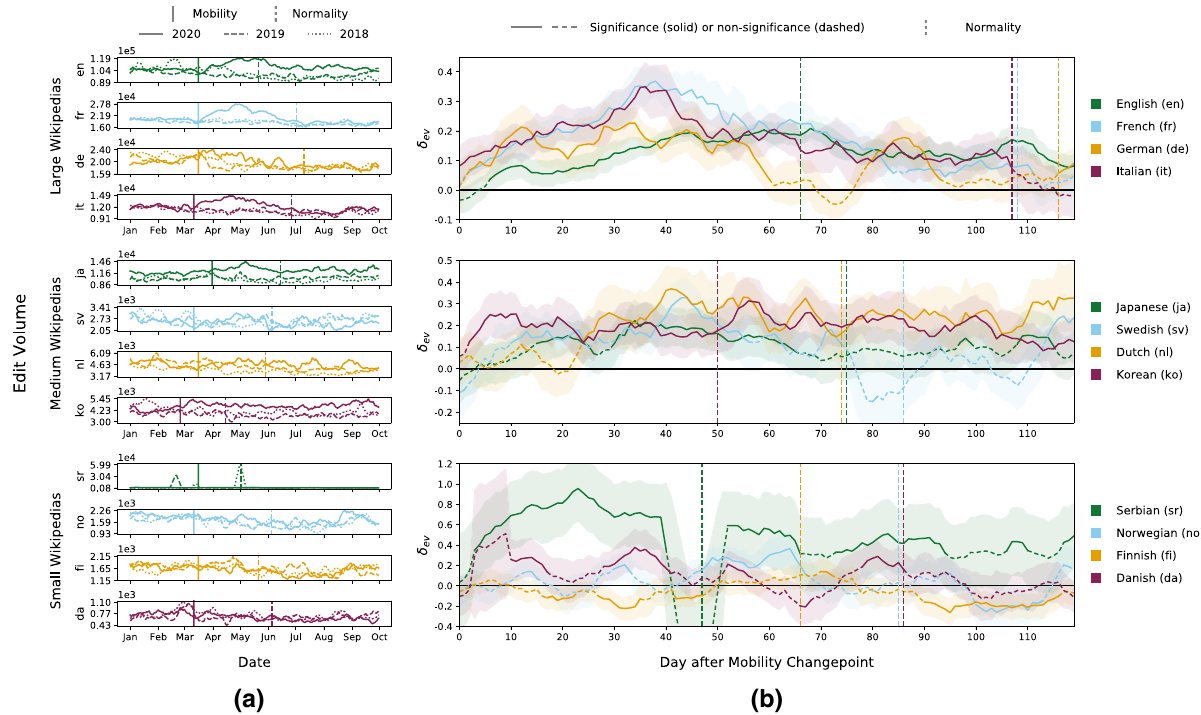
Figure 2. Edit volume during COVID-19 mobility restrictions. We show edit volume findings in large (top), medium (middle), and small (bottom) Wikipedias during COVID-19 mobility restrictions, which in the figure we delineate using mobility (when restrictions become effective) and normality (when restrictions are lifted) changepoints. ( a ) We show rolling 7-day average edit volume generated by human editors for 2018, 2019, and 2020 until October. After a slight retraction of editing around mobility changepoints in most Wikipedias, the number of contributions recovers to previous levels within a few days. Editors contribute substantially more in all large and some medium Wikipedias in the weeks after the mobility restrictions in 2020, compared to historical baselines (Serbian Wikipedia experienced several days of high edit activity in May 2018 and February 2019, resulting in the data shown). ( b ) We depict the relative change in edit volume ( ev ) as retrieved from DiD via δ ev (95% confidence interval as two standard deviations) and plot δ ev for 120 left-aligned 7-day windows (see “Methods”), with the x-axis describing days after the respective mobility changepoint. We observe that editing in large and medium Wikipedias significantly increases after their mobility changepoint, while most small Wikipedias show neither significant increase nor